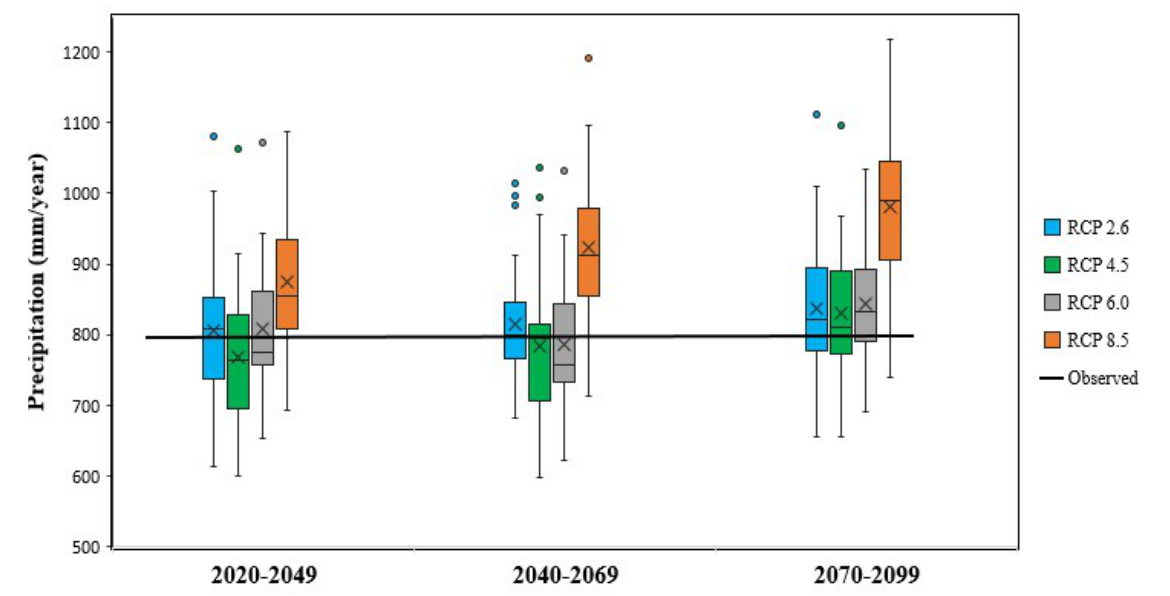
Figure 9. A comparison of projected annual rainfall for each time period (for different GCMs) and the observed historical values. The dots in the figure represent outliers in the data.